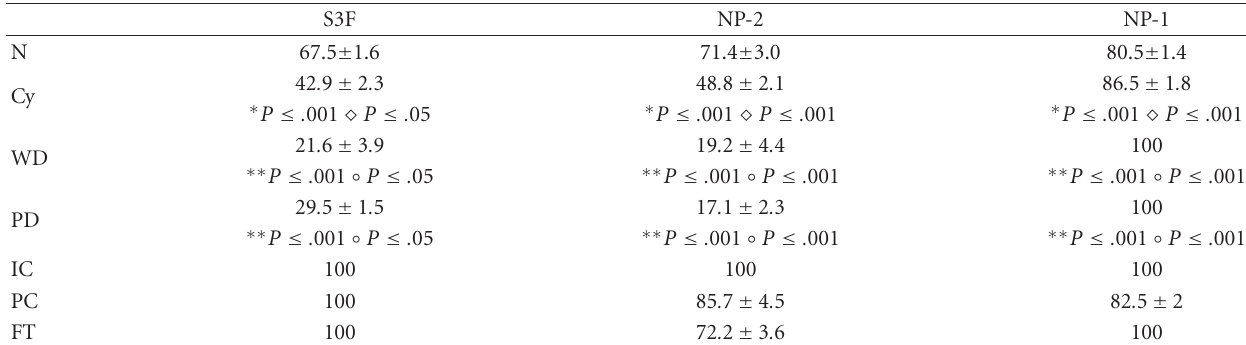
Table 1: Epithelial expression of S3F and NP-2 decreases while NP-1 increases with ovarian epithelial tumor progression.